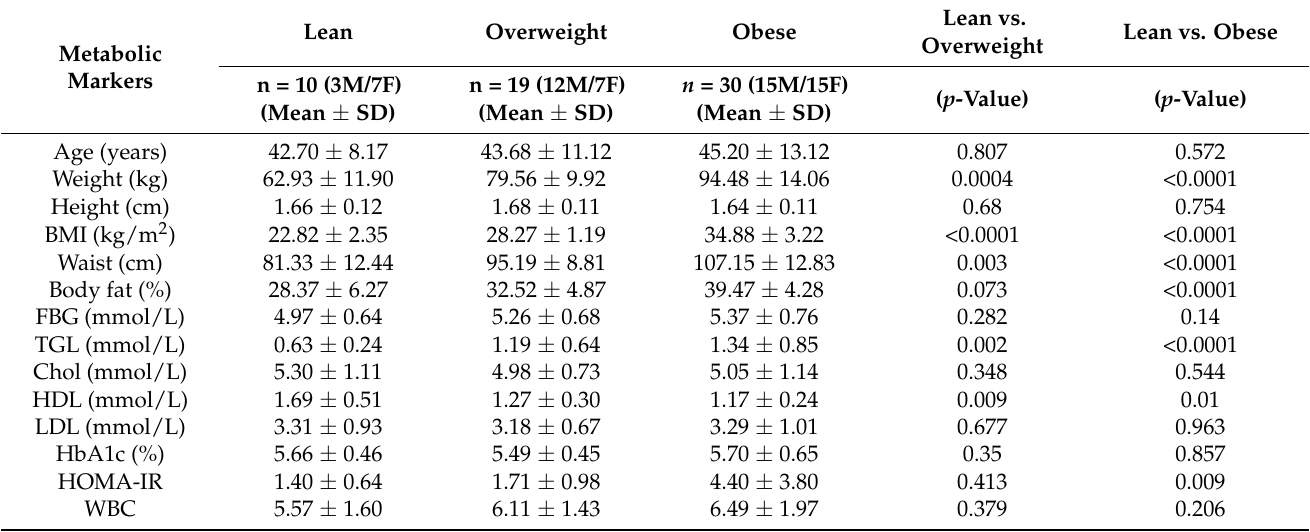
Table 1. Demographic and clinical characteristics of the study population.